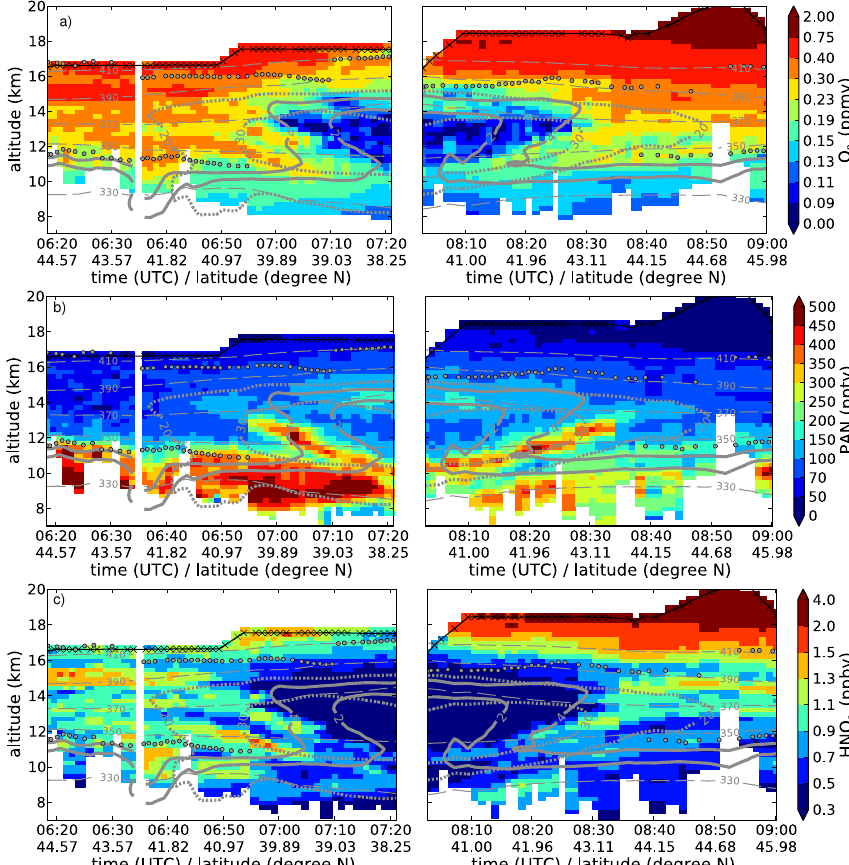
Fig. 5. Retrieved cross sections of O 3 (a) , PAN (b) , and HNO 3 (c) . The left cross section shows the result of the westward pointing measure- ments and the right cross section shows correspondingly the result of the eastward pointing measurements. Retrieved volume mixing ratios are depicted as coloured boxes. A discrete, non-linear colour scale was chosen to better highlight filamentary structures. The abscissa shows time of measurement and latitude at 12km altitude. The altitude of M55-Geophysica at the time of measurement is indicated as a solid black line with crosses marking the time of successfully measured profiles. The position of primary and secondary lapse-rate tropopause are indi- cated by thick grey dots. The dotted grey lines show horizontal ECMWF wind speeds of 20 and 30ms − 1 . The thick solid grey contour lines show ECMWF potential vorticity of 2 and 4PVU. The thin dashed grey contour lines shows ECMWF isentropes. To generate the contours, the ECMWF model data were interpolated temporally and spatially to the horizontally closest tangent point. The white gap at 06:35UTC marks a change in heading of the aircraft by 16 ◦ where a profile was lost.